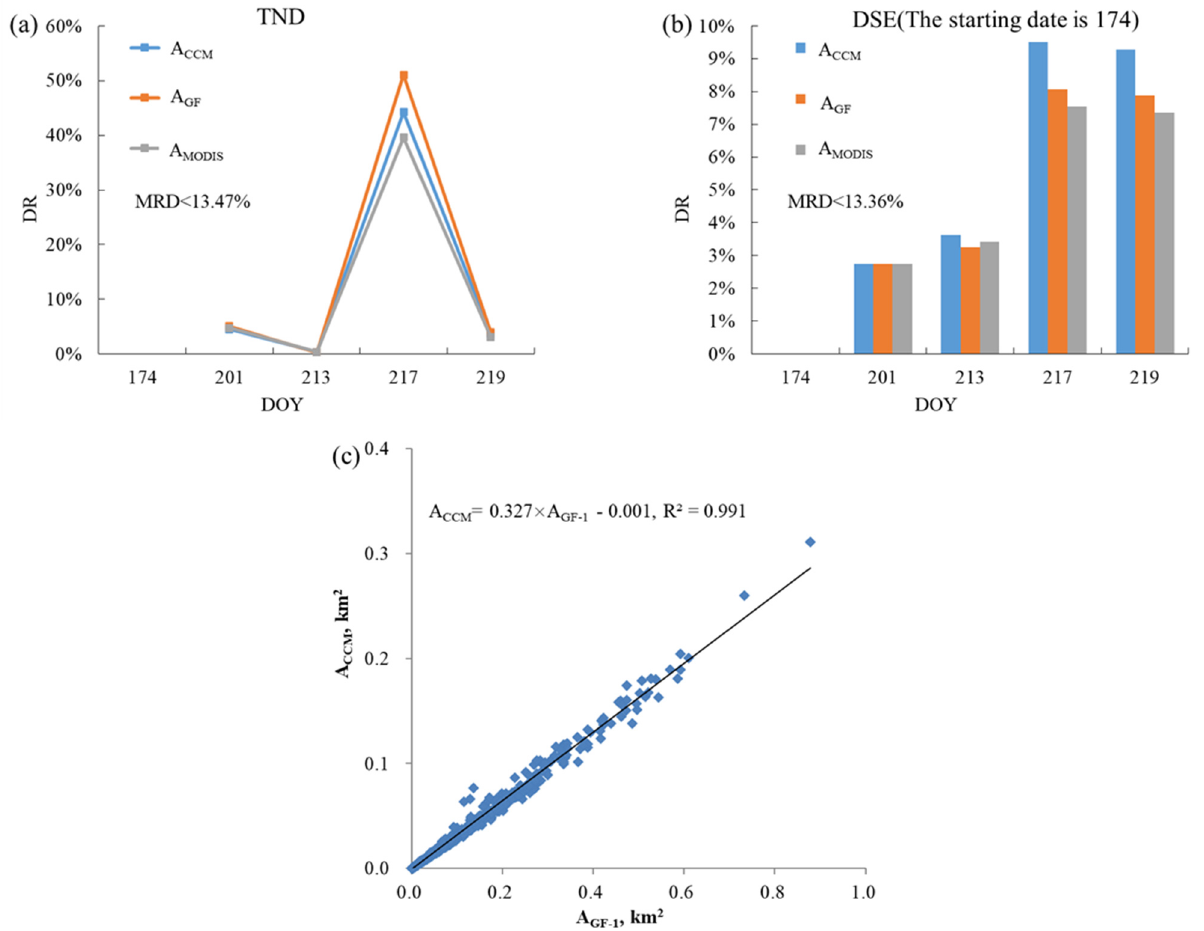
Figure 3. Consistency analysis of the daily dissipation rate (DR) calculated by A T and A CCM . ( a )The DR in a period between every two neighboring dates (TND). ( b ) The DR calculatedduring the periods from the same starting date (i) to different ending dates (DSE). ( c ) Comparison of the macroalgae coverage area and the sub-pixel coverage, i.e., A GF-1 and A CCM , re- spectively. 2.4. .Analysis of the Spatiotemporal Variation in MABs Dissipation.